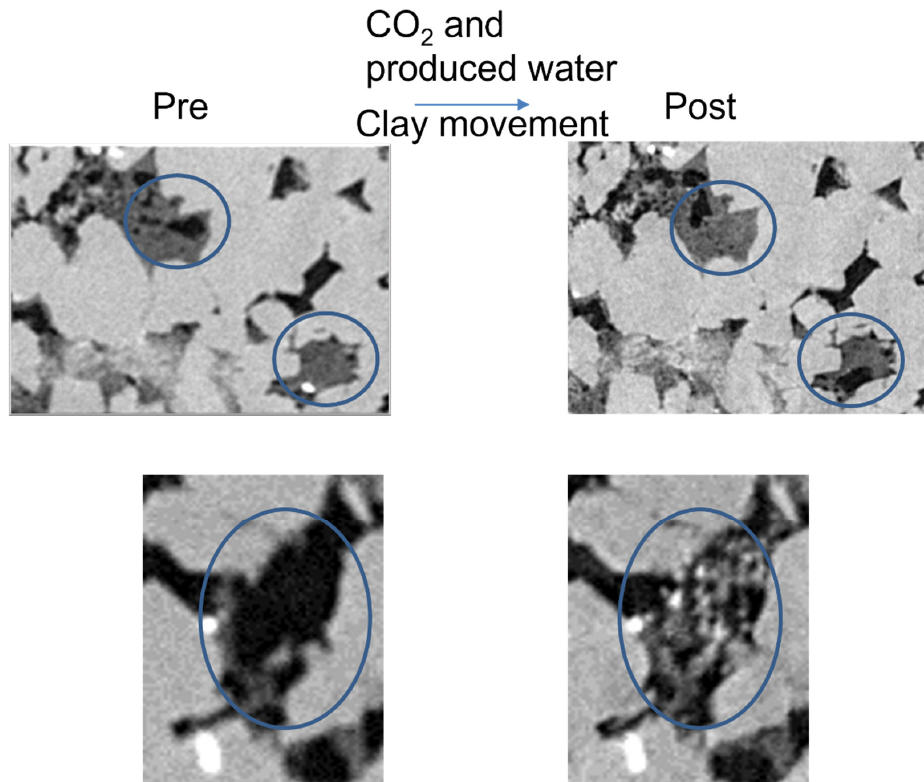
Figure 7. Pre- and post-reaction tomogram horizontal (z) plane magnified regions showing changes and movement of pore filling and bridging clays and grains. Image widths are 1 mm ( top ), and 20 µ m ( bottom ).